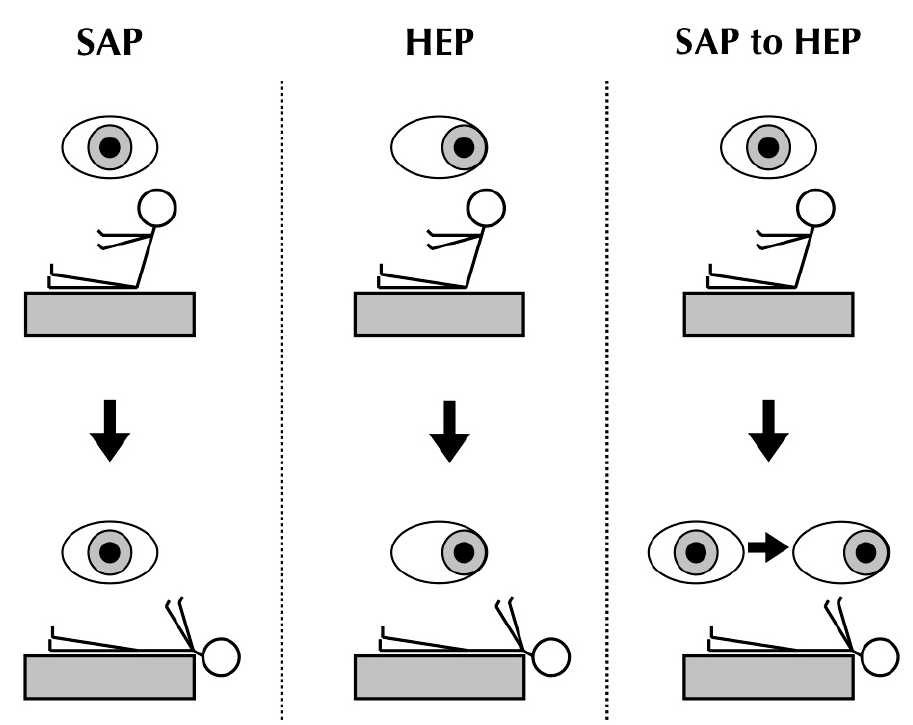
Figure 1. Positional tests performed. The figure represents the different positions of the head and the gaze of each subject during the tests.